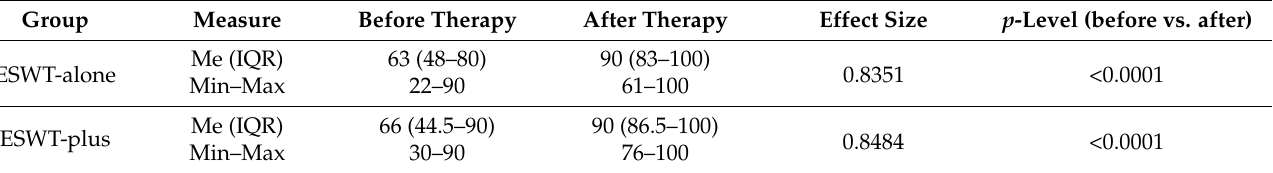
Table 6. Assessment of the AOFAS index (total score) before and after therapy in the compared